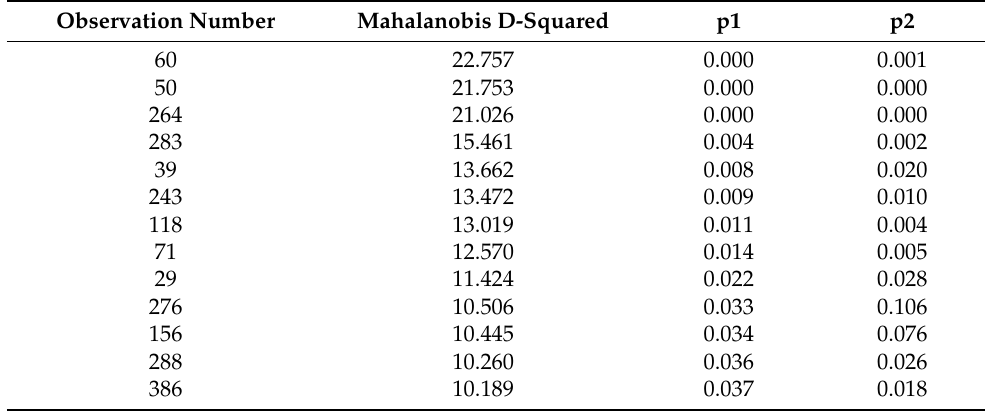
Table 2. Detection of